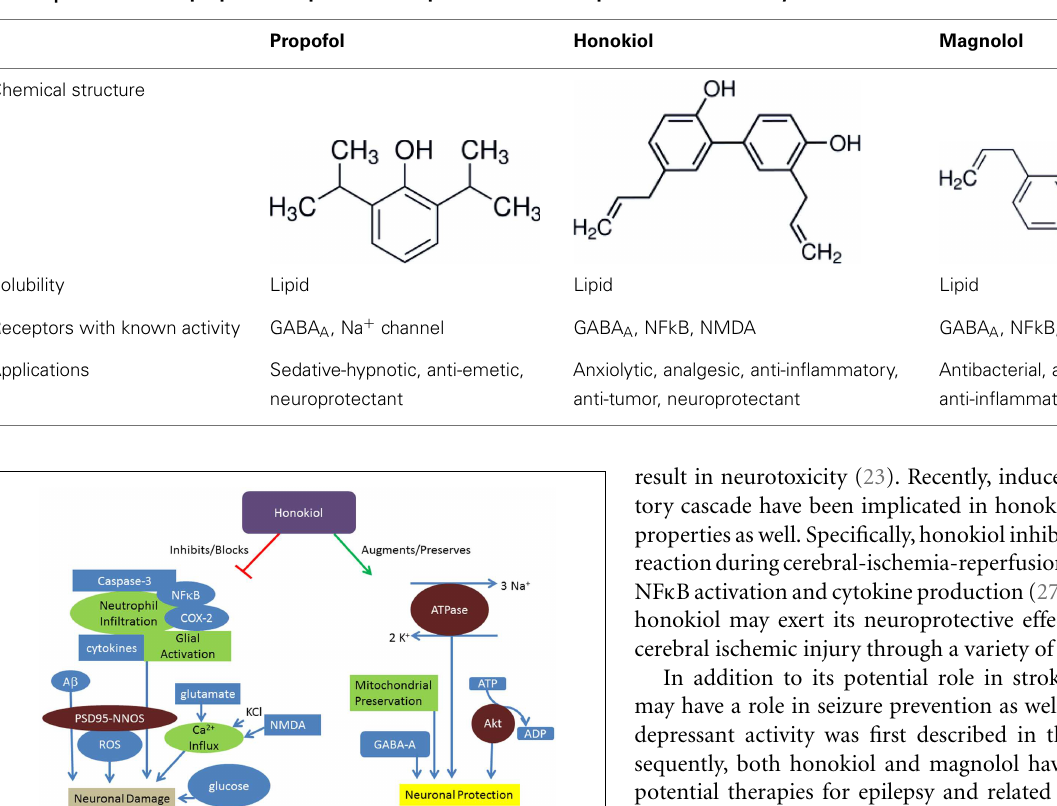
Table 1 | Structure and properties of phenolic compounds with neuroprotective bio-activity.